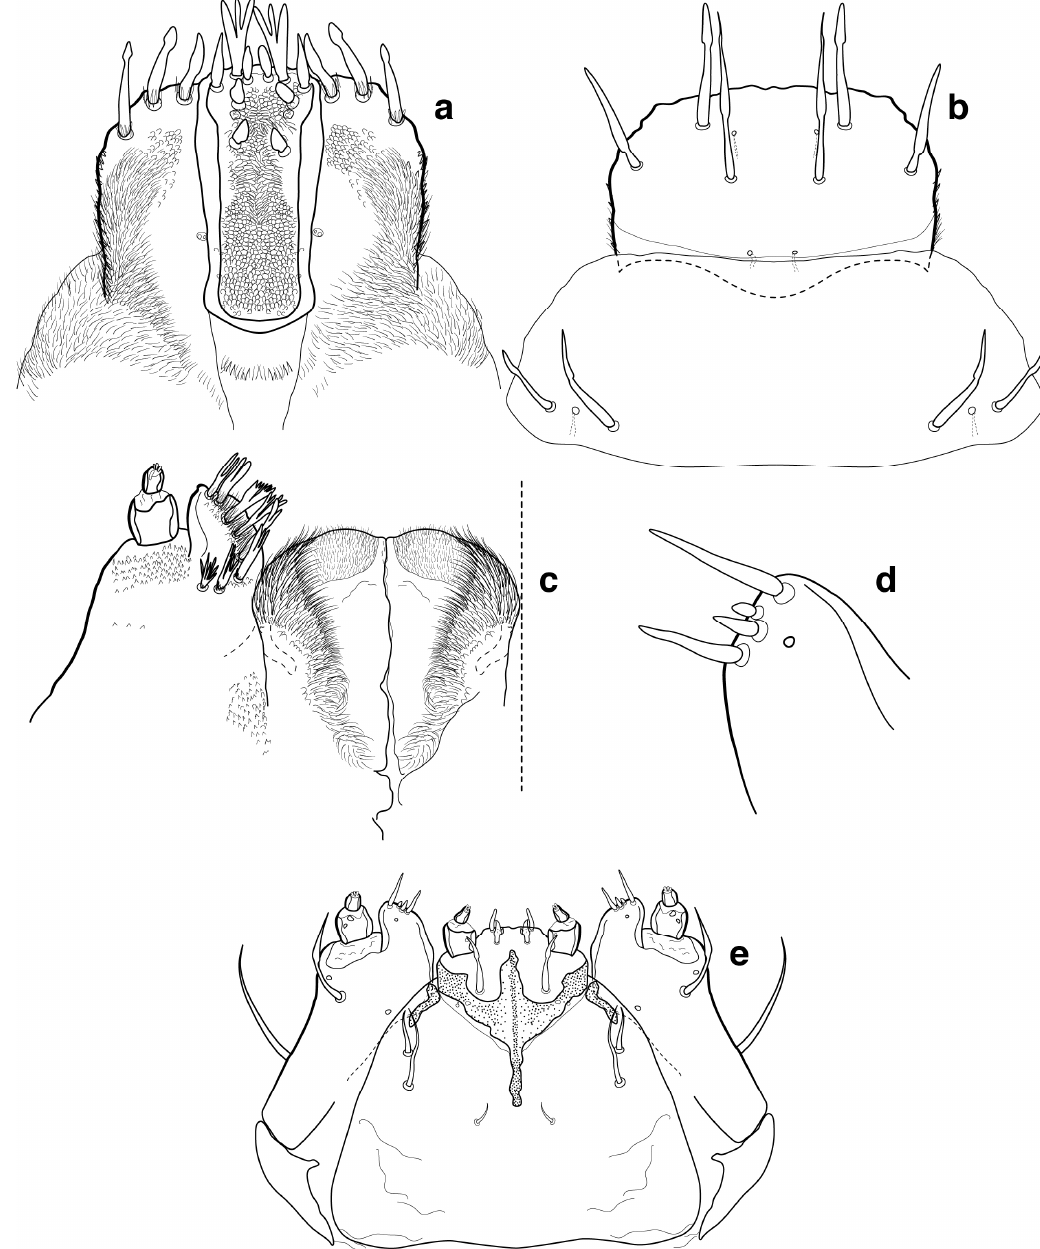
Figure 80. Scyphophorus acupunctatus mouthparts: ( a ) epipharynx; ( b ) clypeus and labrum; ( c ) mala, maxillary palp, and hypopharynx, dorsal view; ( d ) detail of mala and ventral malar setae; and ( e ) labio-maxillary complex, ventral view.